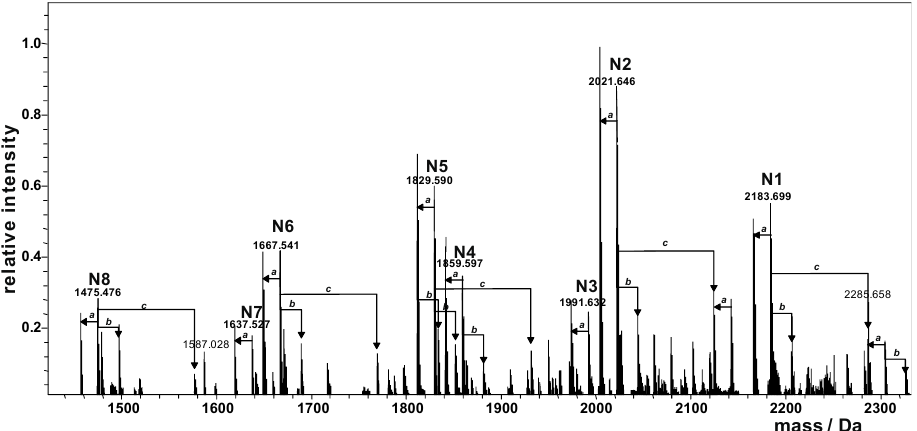
Scheme 2. Structures of acetic acid hydrolysed LPS fraction (L-OS AcOH ) isolated from the E. amylowora Ea ∆ waaL mutant.